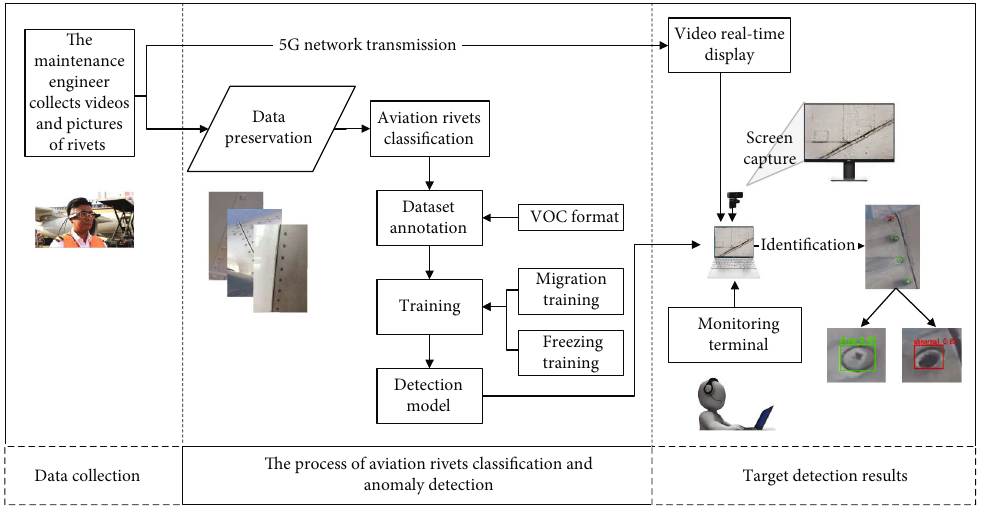
Figure 1: Flow chart of aviation rivet target detection.